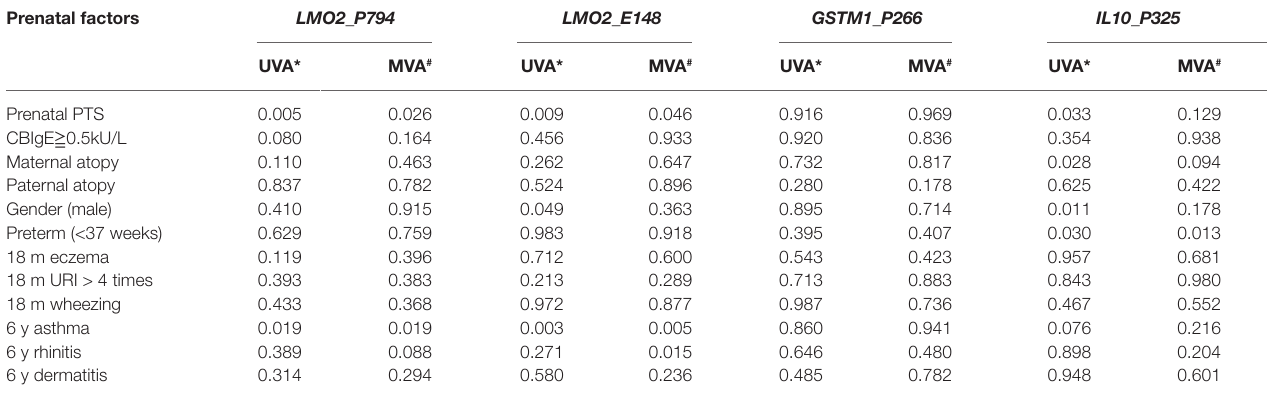
TABLE 3 | Correlation of the CpG methylation levels of LMO2_P794 , LMO2_E148 , GSTM1_P266 , and IL10_P325 to prenatal PTS and allergic diseases. Prenatal